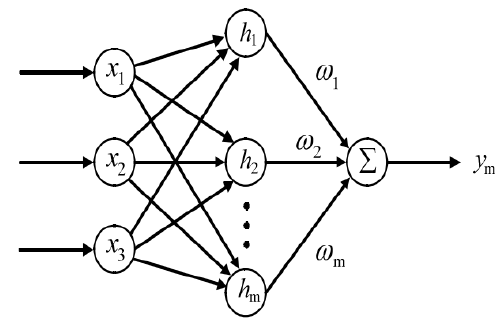
Figure 6. RBF neural network structure.